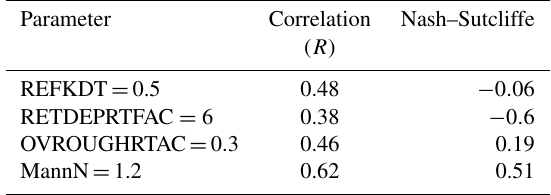
Table 5. The correlation coefficient and the Nash–Sutcliffe test be- tween the observed hydrograph and the simulations for the optimum values of each parameter for Rafina